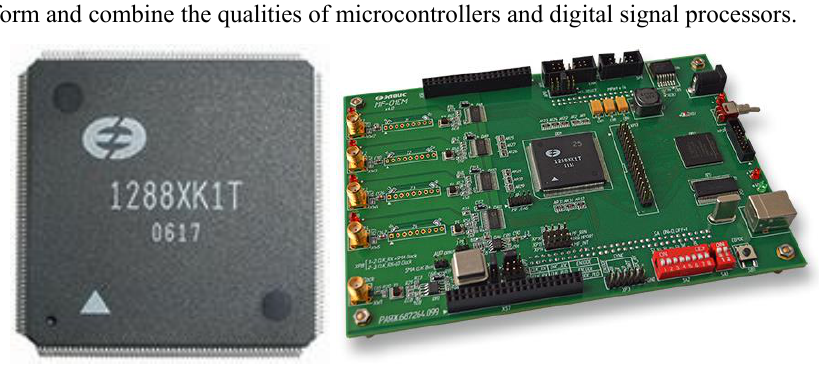
Fig. 1. 1288 ХК 1 Т IC and evaluation board